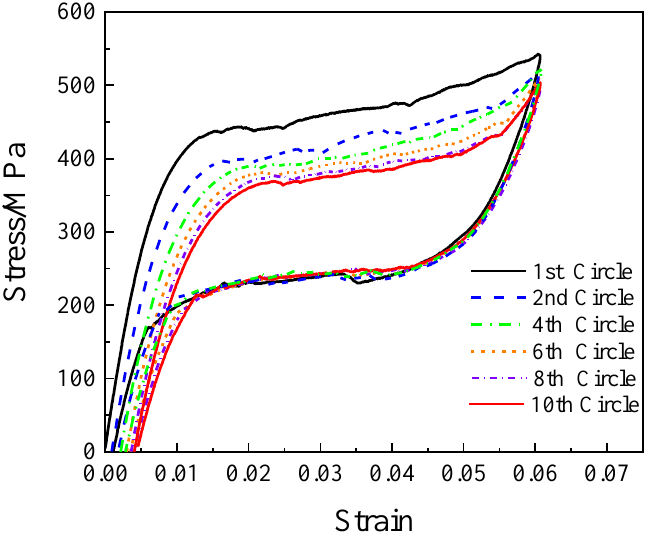
Figure 1. Tensile test of shape memory alloy (SMA) material.